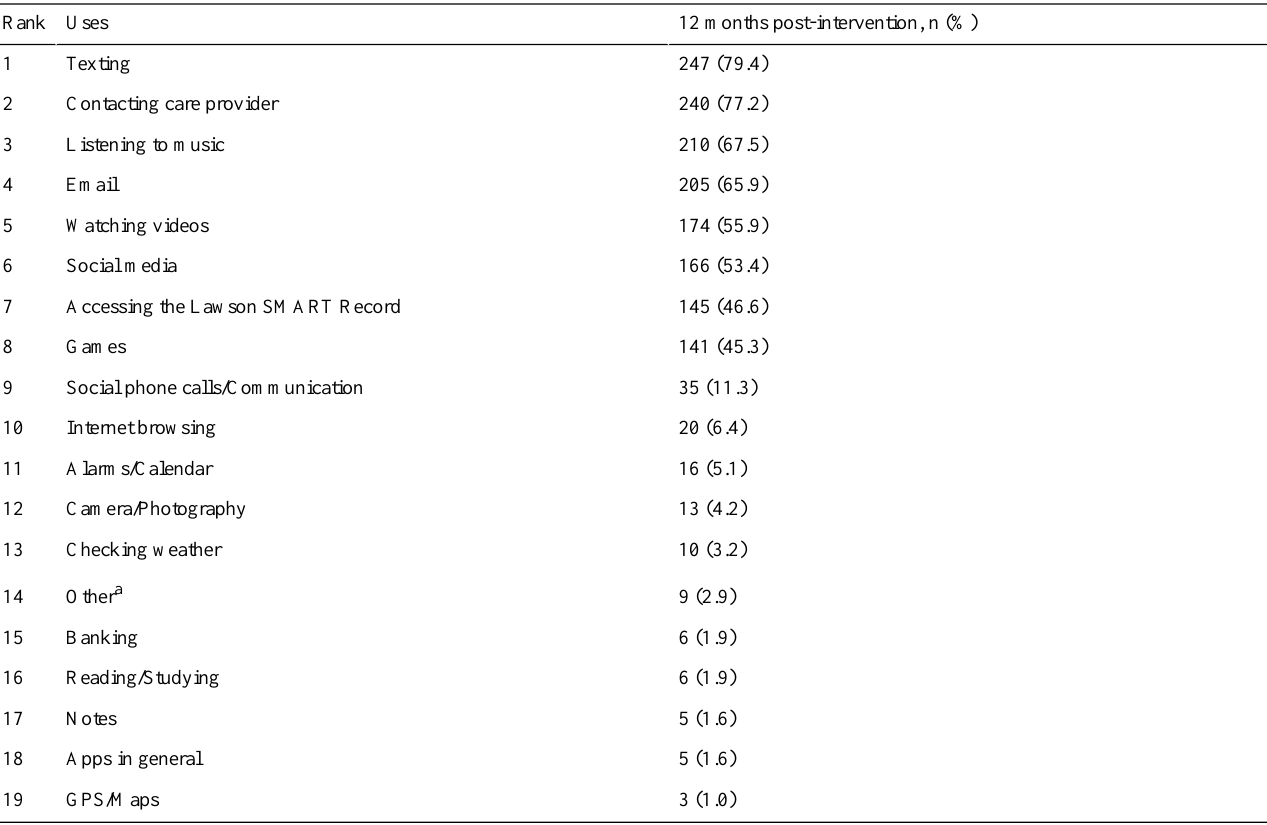
Table 5. Most common uses of the